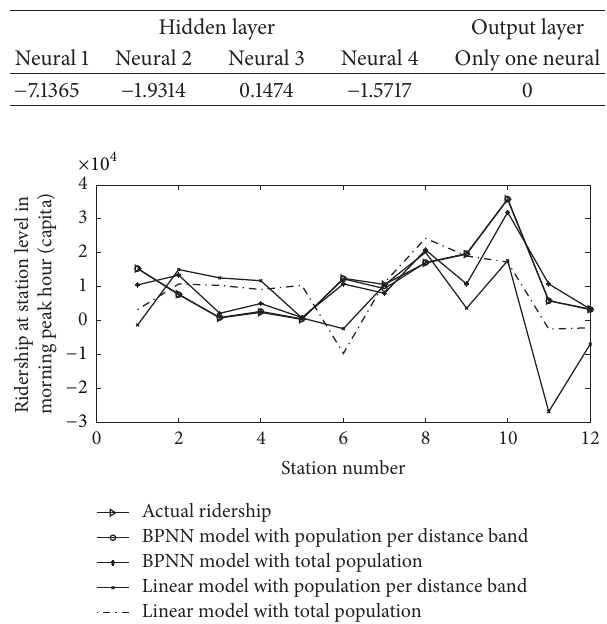
Table 5: Bias for layers.